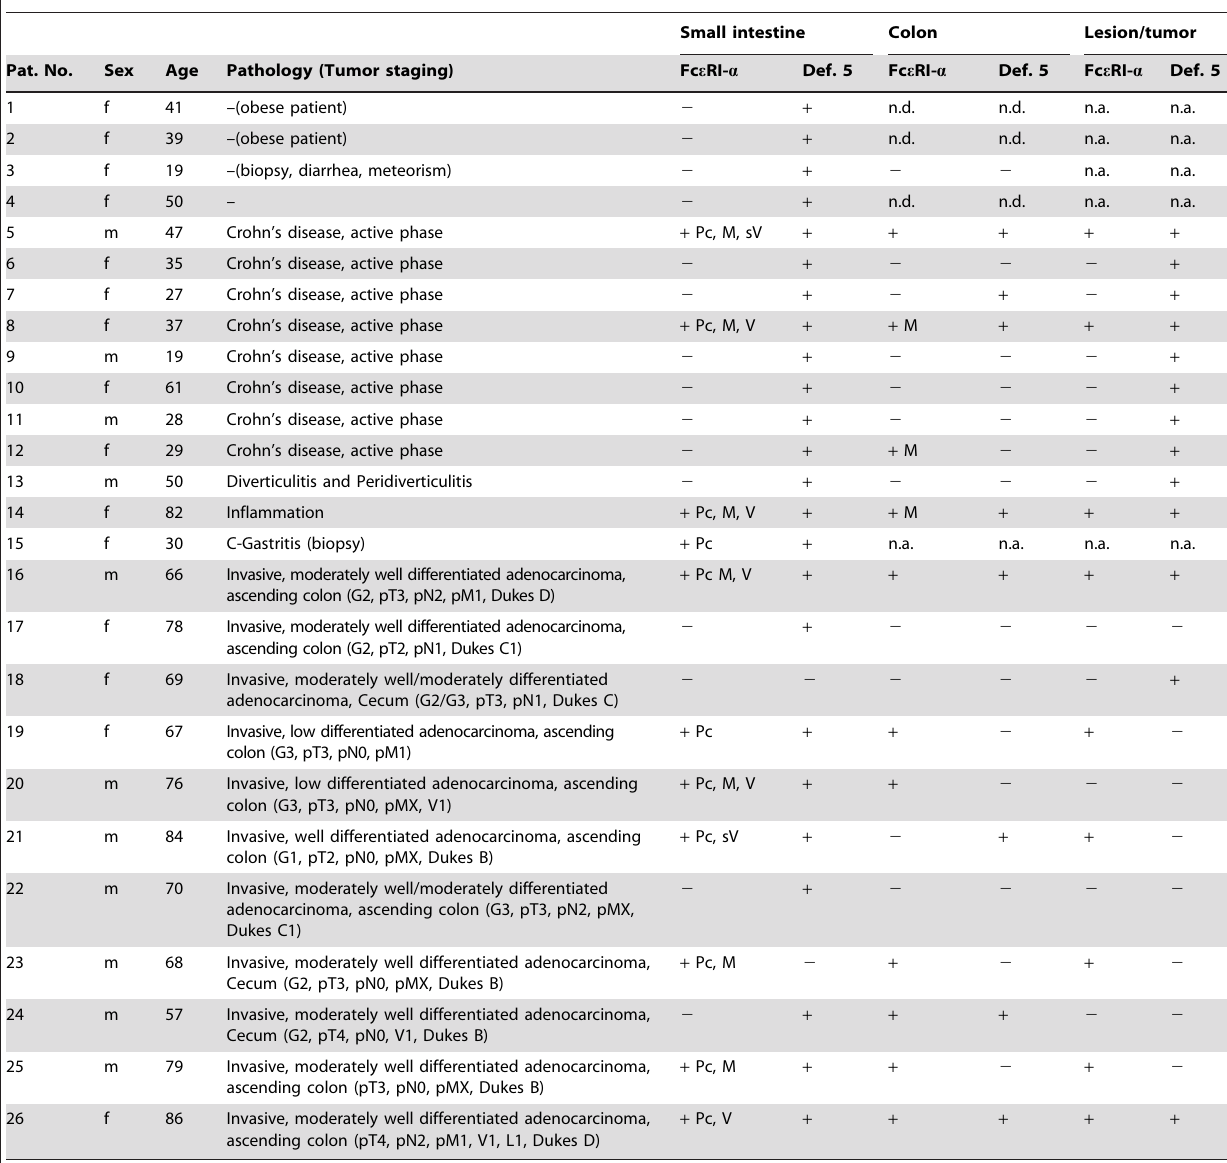
Table 1. Patients’ characteristics and staining